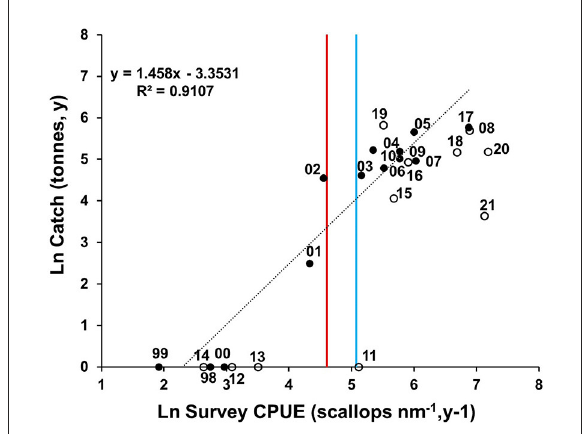
FIGURE6 Denham Sound catch prediction model prior to fishery going to catch quota based on November survey abundance of 0 + and 1 + scallops nm − 1 between 1997 to 2010 (black dots, closed years excluded) when a consistent spatial area was open to scallop fishing. Limit (red vertical line) and threshold (blue vertical line) reference levels indicated. Years under quota management excluded from the catch prediction relationship is indicated by open circles.